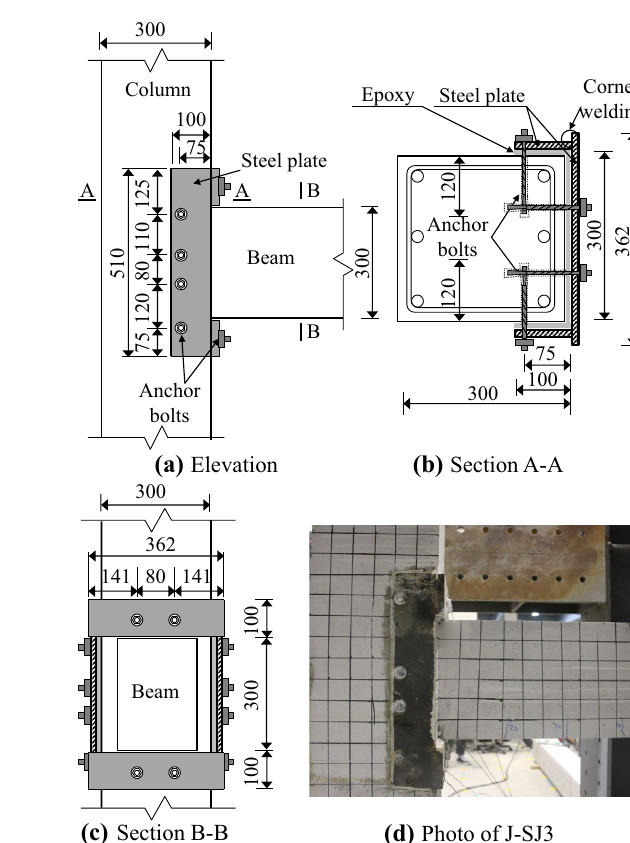
Fig. 7 Details of retrofitted specimen J-SJ2.